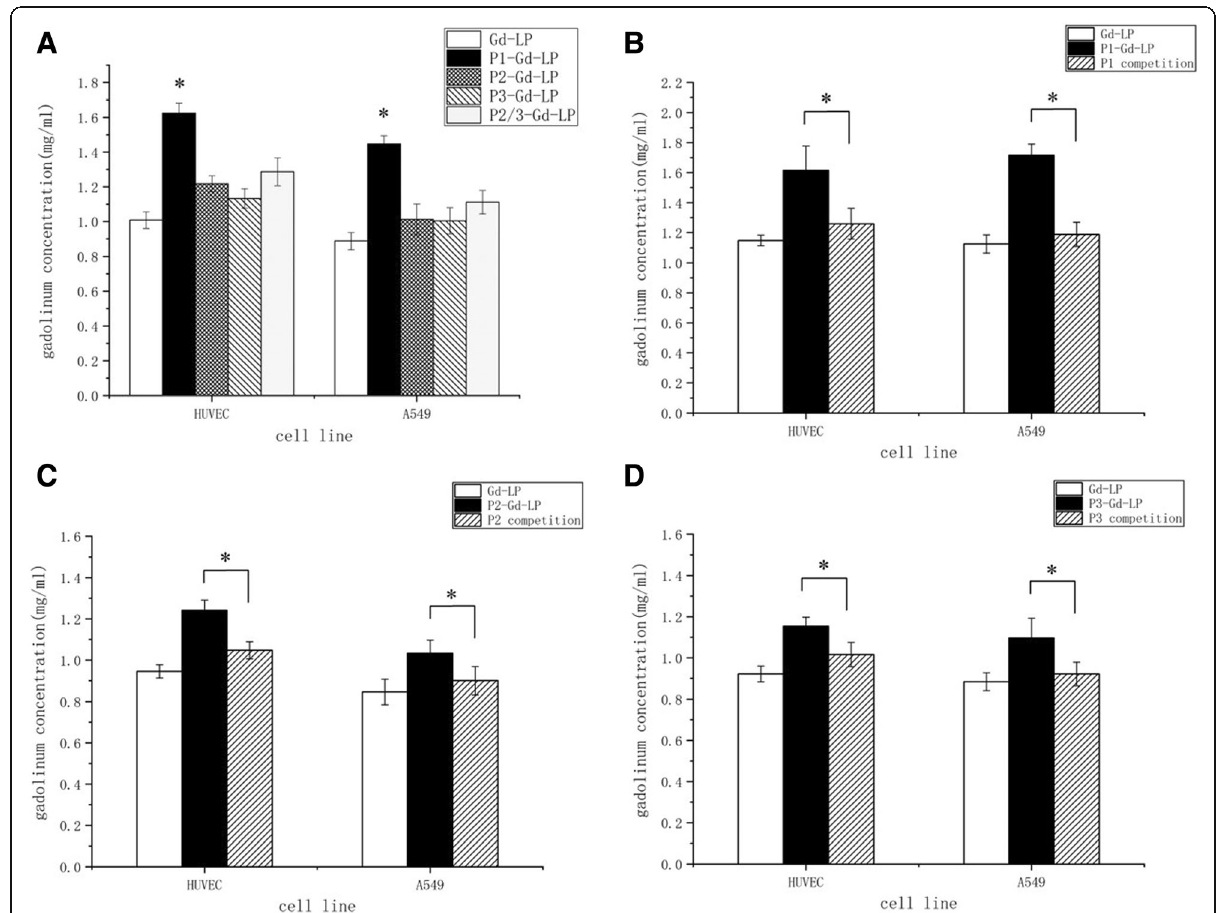
Fig. 2 a Cellular uptake experiments of Gd-LP, P1-Gd-LP, P2-Gd-LP, P3-Gd-LP, and P2/P3-Gd-LP in A549 cells and HUVECs. b - d Cellular competition study of P1-Gd-LP, P2-Gd-LP, and P3-Gd-LP, with P1, P2, and P3 respectively added to inhibit receptors in the competition